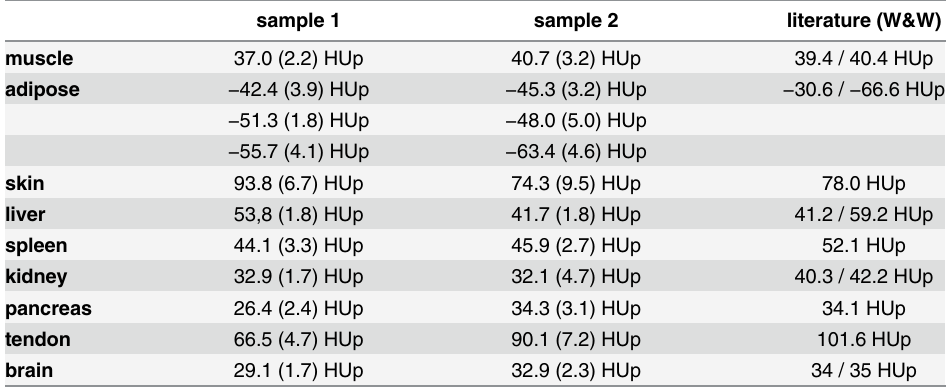
Table 3. Phase-contrast Hounsfield units of various human soft tissue types evaluated from measure- ments and calculated from tabulated literature data. Ten regions-of-interest were analysed for each tis- sue type and measurement. The listed numbers are the mean values and standard deviations (round brackets) of the regions ’